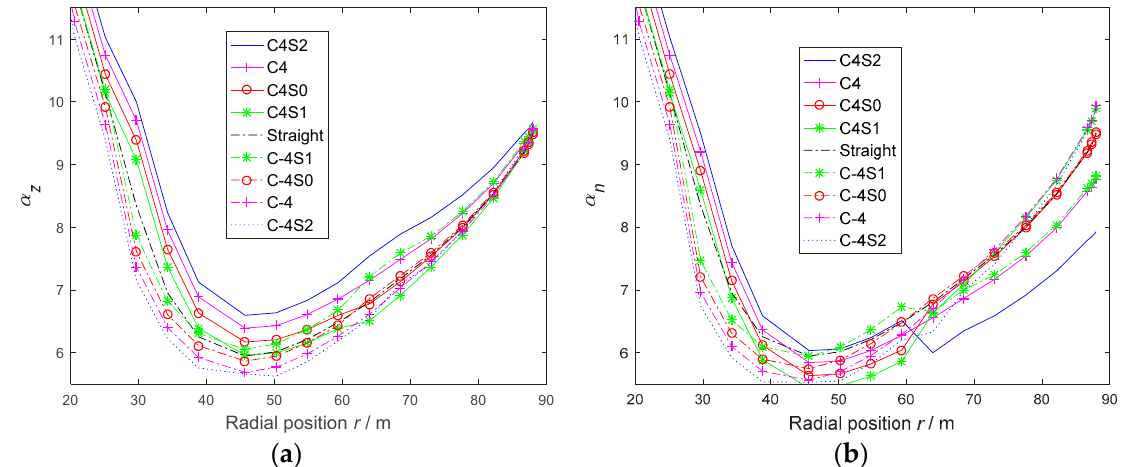
Figure 13. Distributions of angle of attack: ( a ) α z ; ( b ) α n .